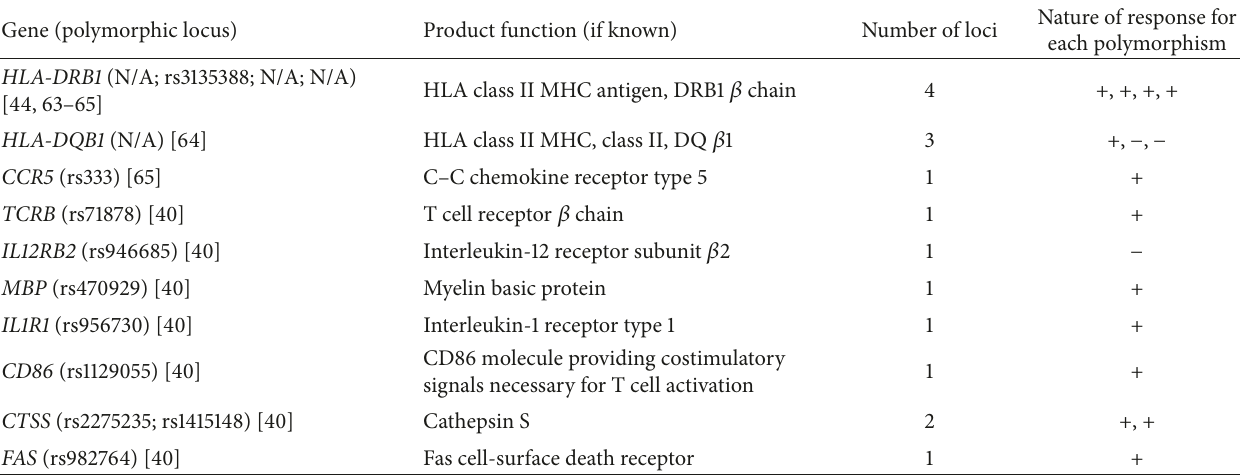
Table 6: Genes with polymorphisms showing significant association with response to glatiramer acetate in patients with multiple sclerosis